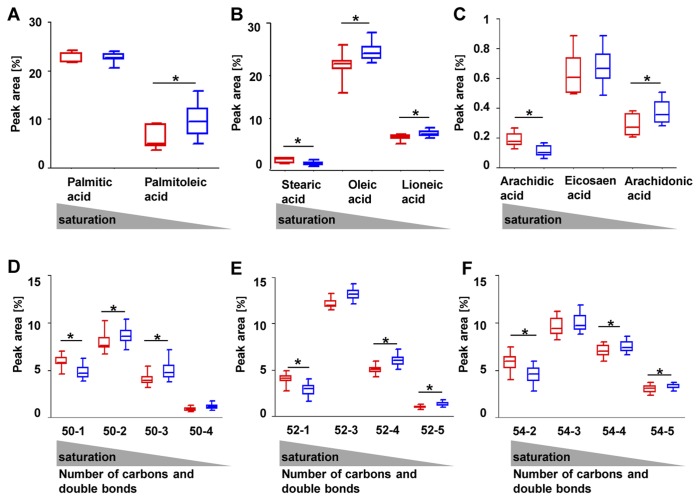
RP-HPLC-MS (Reverse phase high-performance liquid chromatography-mass spectrometry) of abdominal and gluteal fat samples.Red colors represent abdominal depots, blue colors represent gluteal depots. A,B,C Boxplots show fatty acid saturation of abdominal and gluteal adipose tissue. D,E,F Boxplots show triglyceride saturation of abdominal and gluteal adipose tissue. First numbers indicate the number of atomic carbons, second numbers indicate the number of double bonds (e.g. 50-1; 50 atomic carbons (50 C), one double bond).